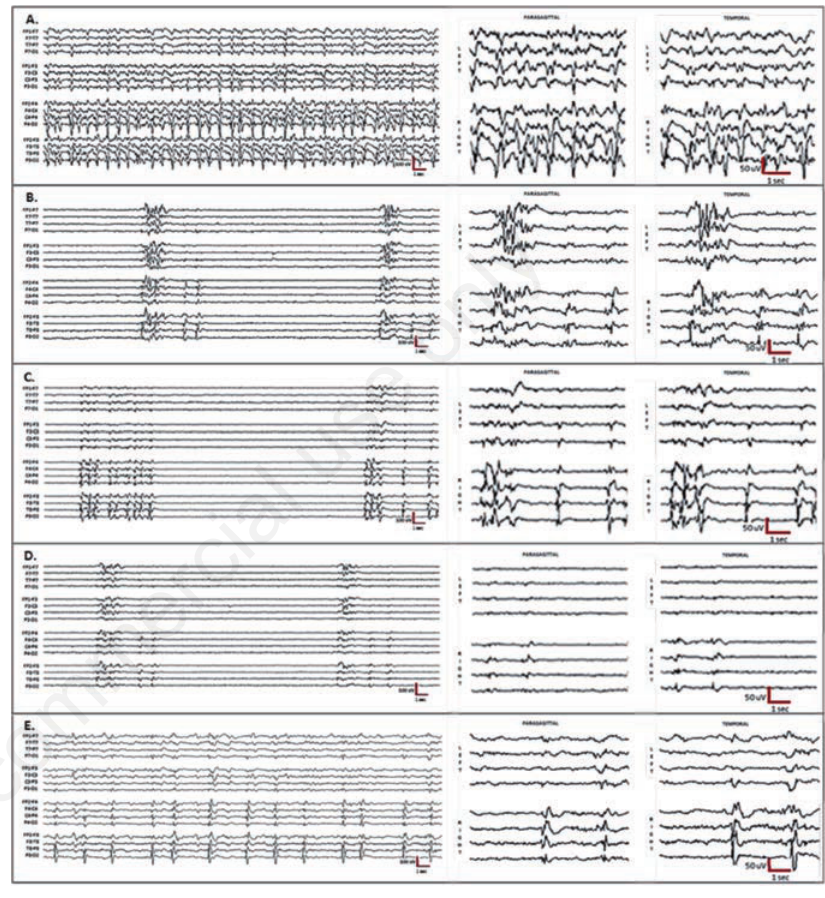
Figure 2. Electroencephalogram (EEG) tracings represent different time points (A-E) dur- ing treatment with antiepileptic and anesthetic drugs. Display settings: 16-channel lon- gitudinal bipolar montage; filters at 1-Hz high-pass, 70-Hz low-pass, 60-Hz notch; sen- sitivity at 7µV/cm; voltage-time scale: 100 µV/1 sec for the full tracings and 50 µV/1 sec for the magnified epochs. The EEG is shown on the left as a 16-channel trace with the channels separated from top to bottom into the following groups: left temporal, left parasagittal, right parasagittal, and right temporal. For clarity, the final 6 seconds of each tracing are magnified and displayed as two 8-channel traces: parasagittal (left over right) derivations in the middle column and temporal (left over right) derivations in the right column. A) After levetiracetam was loaded, but before infusion of anesthetic antiepileptic drugs, periodic lateralized epileptiform discharges (PLEDs) were present on the right and maximum in the right posterior temporal region. B) Propofol resulted in asymmetric drug-induced burst suppression with surviving remnants or fragments of PLEDs on the right that are mixed with other burst components increasing the overall amplitude and complexity of bursts on the right. C) The addition of phenytoin, lacosamide, and keta- mine reduced the rate and complexity of bursts and caused fast rhythms to disappear but failed to completely suppress the PLEDs remnants. D) The addition of midazolam and topiramate resulted in further reduction of burst rate and complexity and attenuation of burst components. The PLEDs remnants were also attenuated but not completely sup- pressed. E) After withdrawal of anesthesia, the PLEDs started to reacquire their preanes- thesia configuration. The post-anesthesia trace in this figure shows continuous PLEDs with interdischarge interval of 2-3